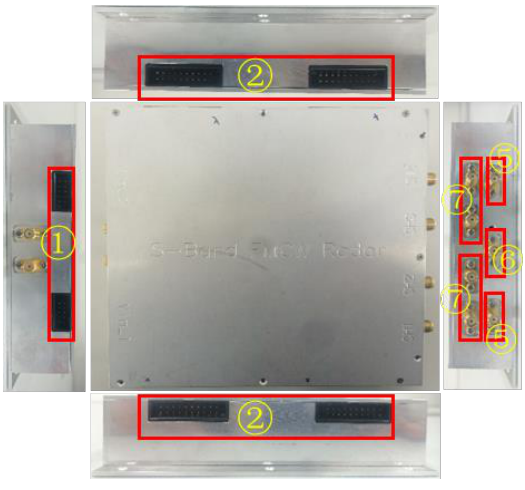
Figure 8. Outward appearance of implemented S-band FMCW TWRI radar system.